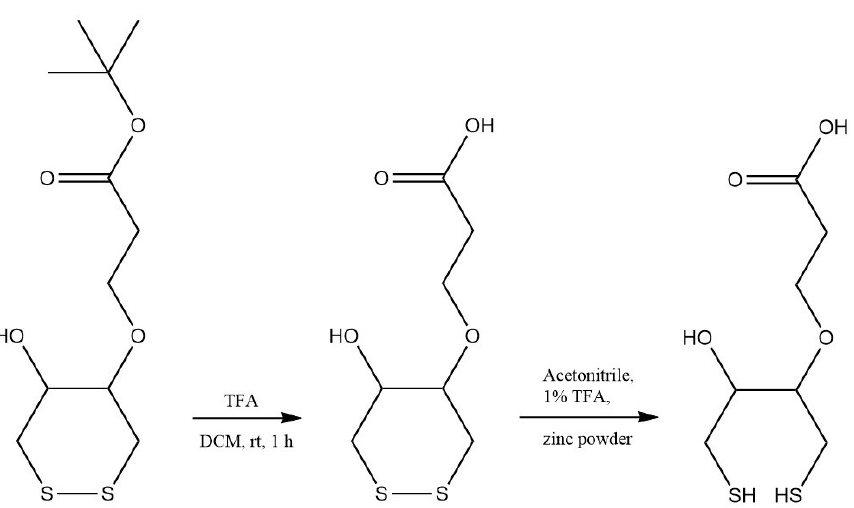
Figure 6. Deprotection and reduction reaction steps to produce DTT COOH .